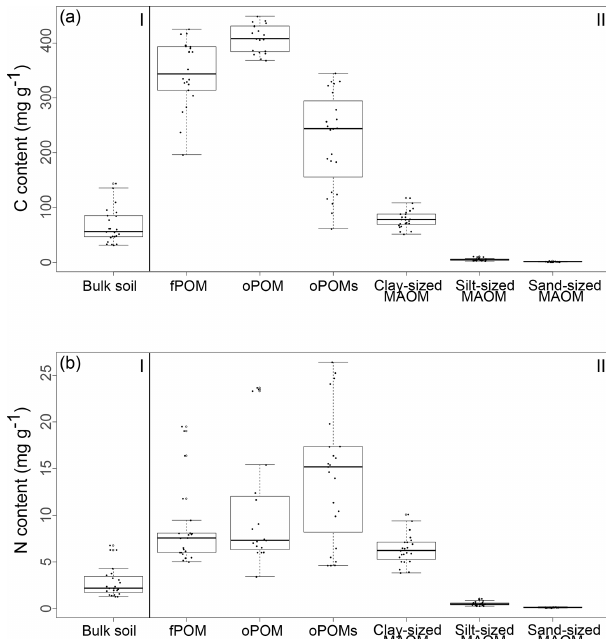
Figure 2. The content (in mgg − 1 ) of C (a) and N (b) of bulk soils (I) and SOM fractions (free particulate OM – fPOM, occluded particulate OM – oPOM, small occluded particulate OM – oPOMs – and clay-sized mineral-associated OM – MAOM)